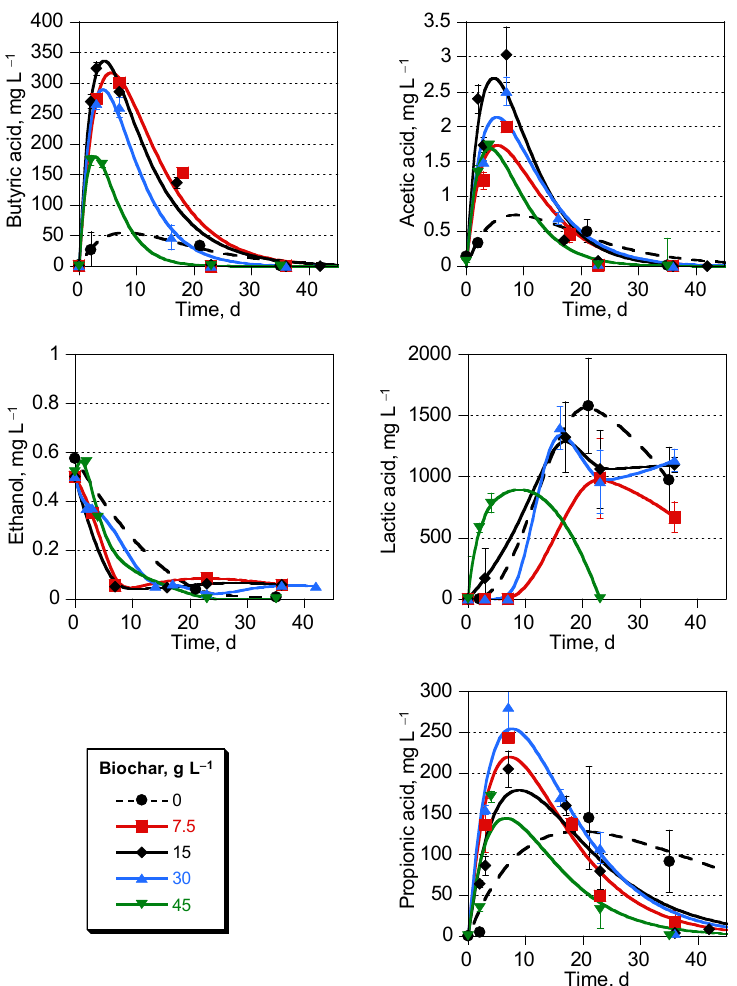
Figure 3. Time courses of butyrate, acetate, ethanol, lactate, and propionate concentrations during digestion with different amounts of biochar.